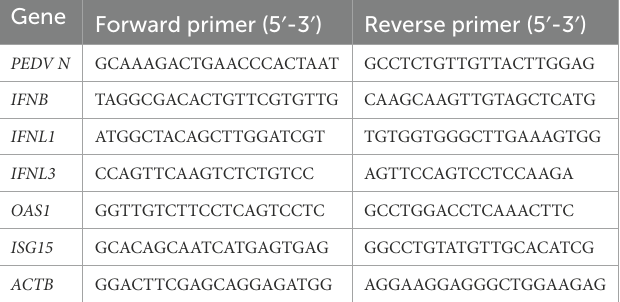
TABLE 1 qPCR primer sets for cytokine genes used in this